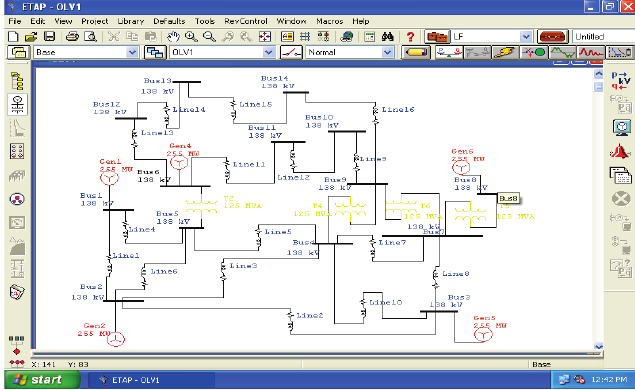
Fig.7. Simulated network in ETAP